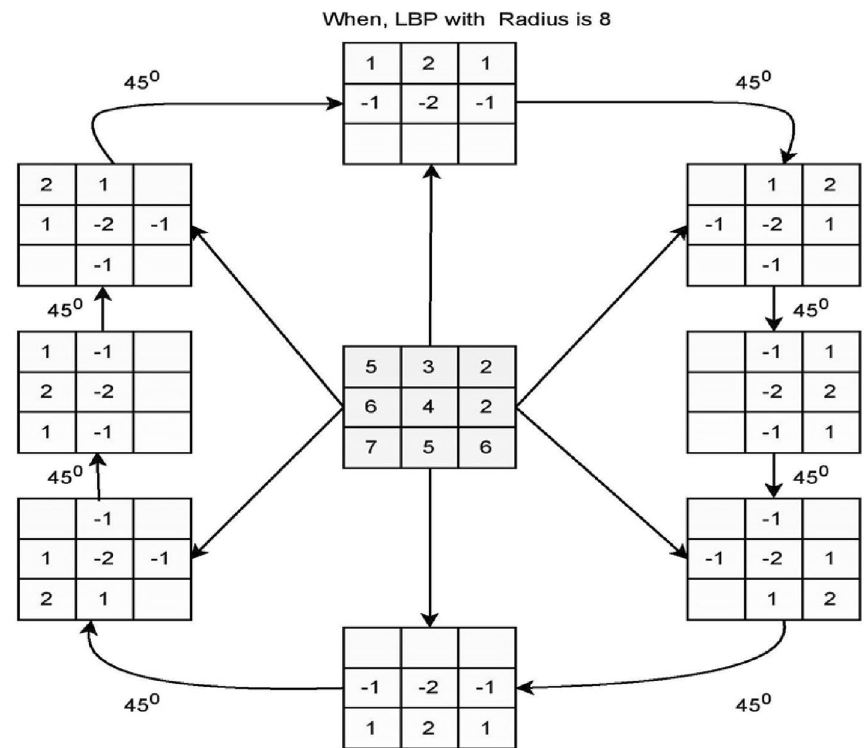
Figure 3. Diagram representing the LBP